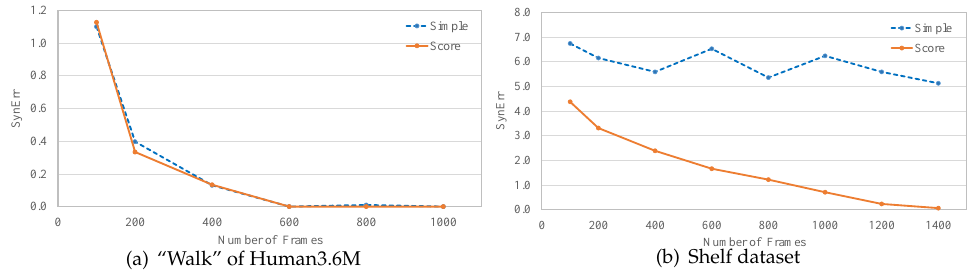
Figure 5. Results for Human3.6M “Walk” action ( a ) and Shelf ( b ) dataset when different numbers of frames are used. For each SynErr datapoint in the graph, we randomly crop the number of corresponding x -axis value frames from original videos and repeat the experiment 50 times to obtain the average SynErr.